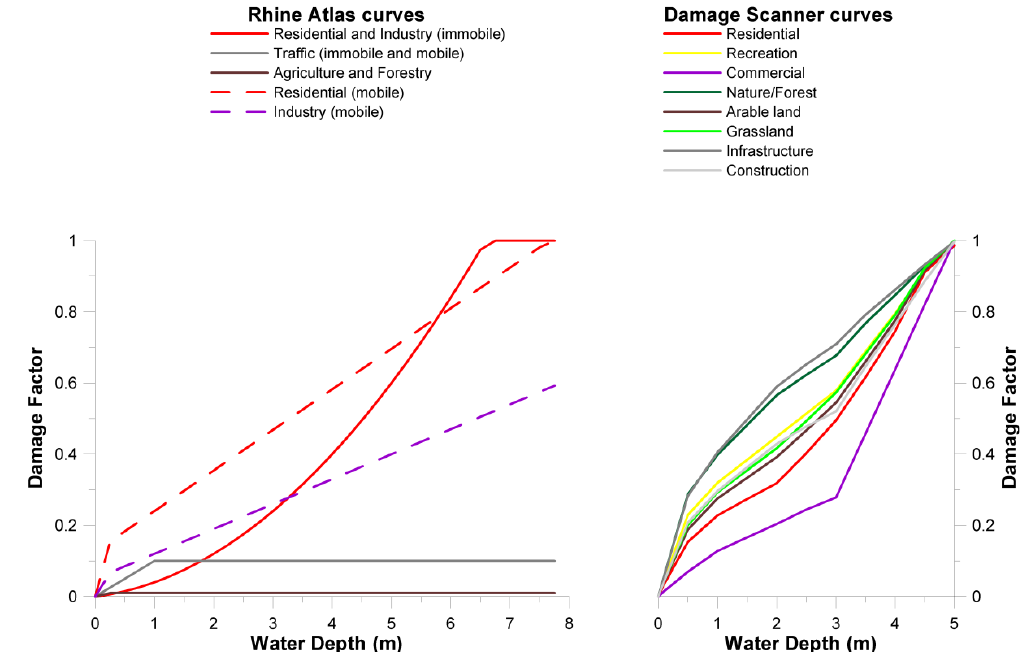
Fig. 3. Damage curves for the Rhine Atlas and the Damage Scanner model (Adapted from de Moel and Aerts,